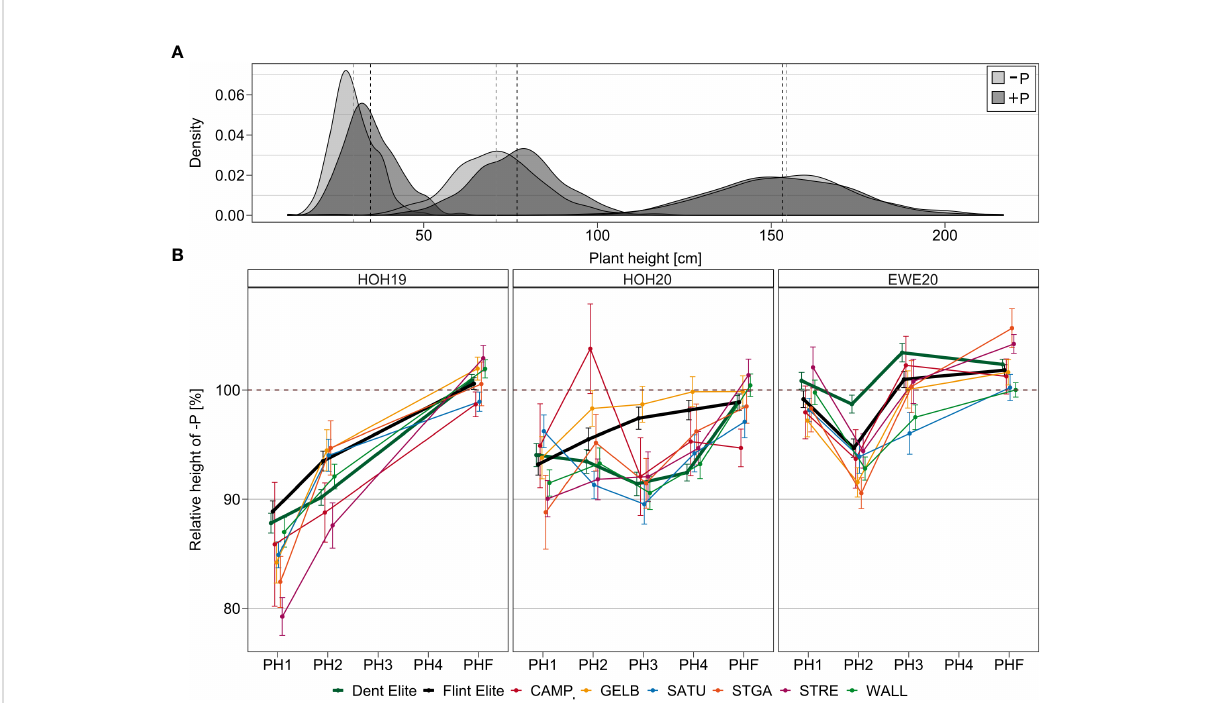
FIGURE 3 Response of plant height to P starter fertilizer. (A) Density plot of plant height distributions in HOH19 at three different time points (PH1, PH2, PHF) in control (-P) and starter fertilized (+P) conditions. Mean values are marked by a dashed line. (B) Relative plant height of genotypes under -P compared to +P treatment in HOH19, HOH20 and EWE20. Bars represent the standard deviation. The dashed line represents the same plant height in -P and +P treatment. Plant height was recorded at three (HOH19), four (EWE20) or fi ve different time points (HOH20) (PH1, PH2, PH3, PH4, PHF). Populations are abbreviated as follows: Campan Galade (CAMP), Gelber Badischer Landmais (GELB), Satu Mare (SATU), St Galler Rheintaler (STGA), Strenzfelder (STRE) and Walliser